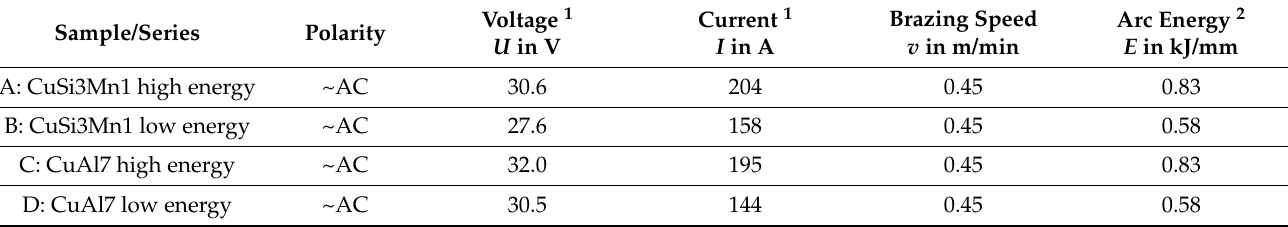
Table 2. Arc brazing